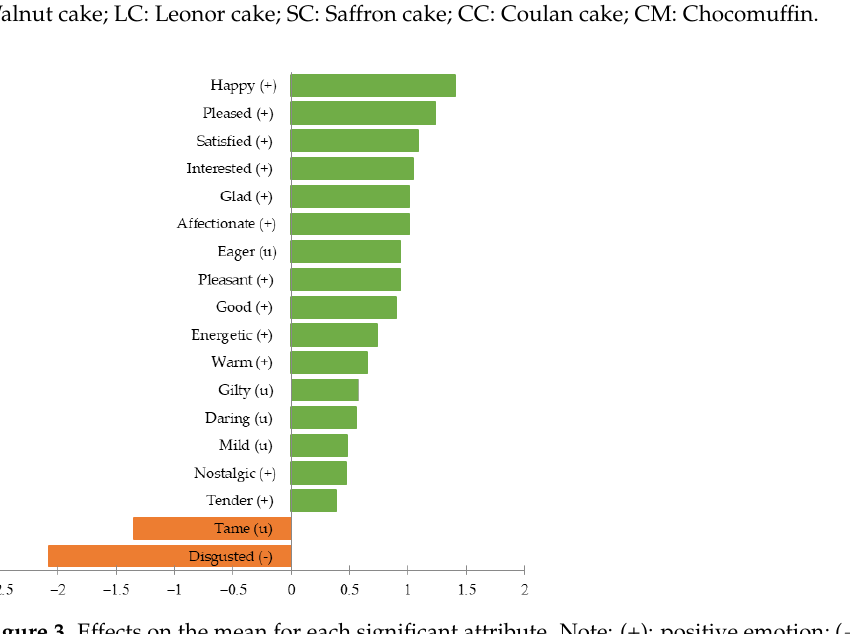
Figure 3. Effects on the mean for each significant attribute . Note: (+): positive emotion; ( − ): negative emotion; (u): neutral emotion.